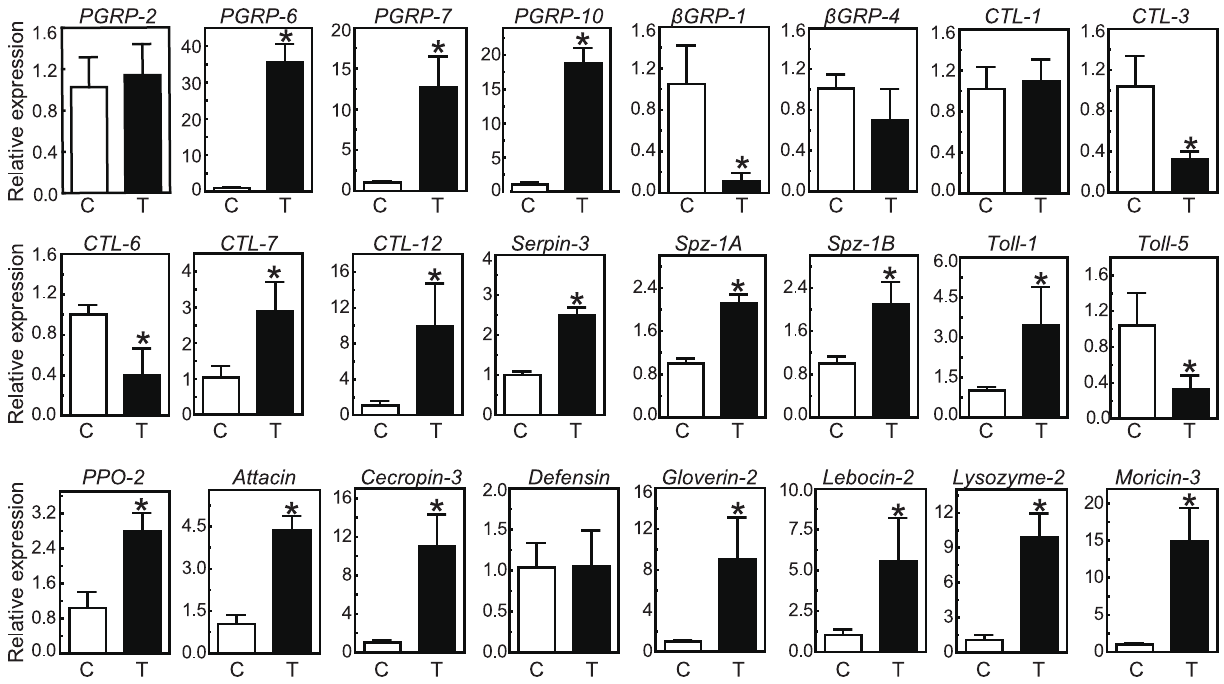
Figure 2. Verification of differentially expressed genes by qRT-PCR. O. furnacalis ribosomal protein L8 ( rpL8 ) was used as an internal standard to normalize the templates. The bars represent the mean 6 S.D. ( n =3). Asterisks indicate means that are significantly different from the control (unpaired t test, P , 0.05). Lack of asterisk indicates the difference is not significant (unpaired t test, P . 0.05).